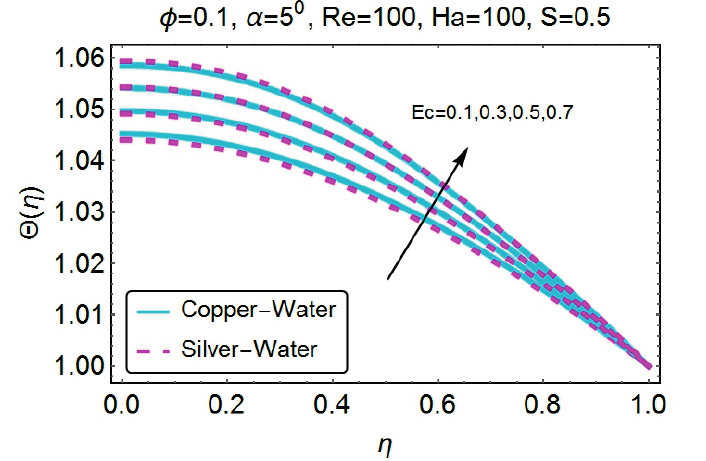
Figure 24. Change in temperature for varying Ec (divergent channel/stretching